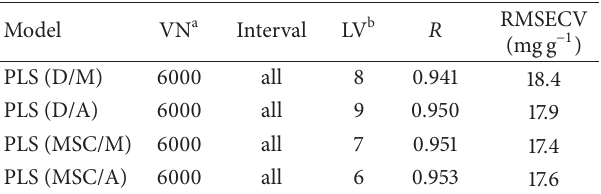
Table 1: Results obtained using full-spectrum PLS model for pro- pranolol hydrochloride determination by FTNIR/PROBE.